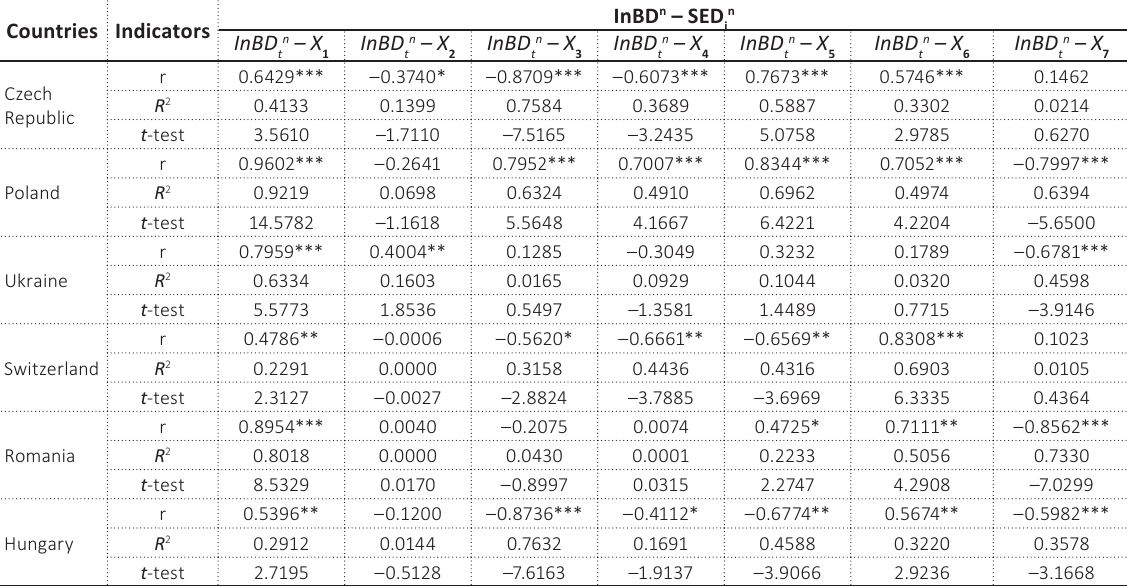
Table 3. The strength of the link between the level of the banking sector development and the parameters of social and economic development in some EU countries, Switzerland, and Ukraine,